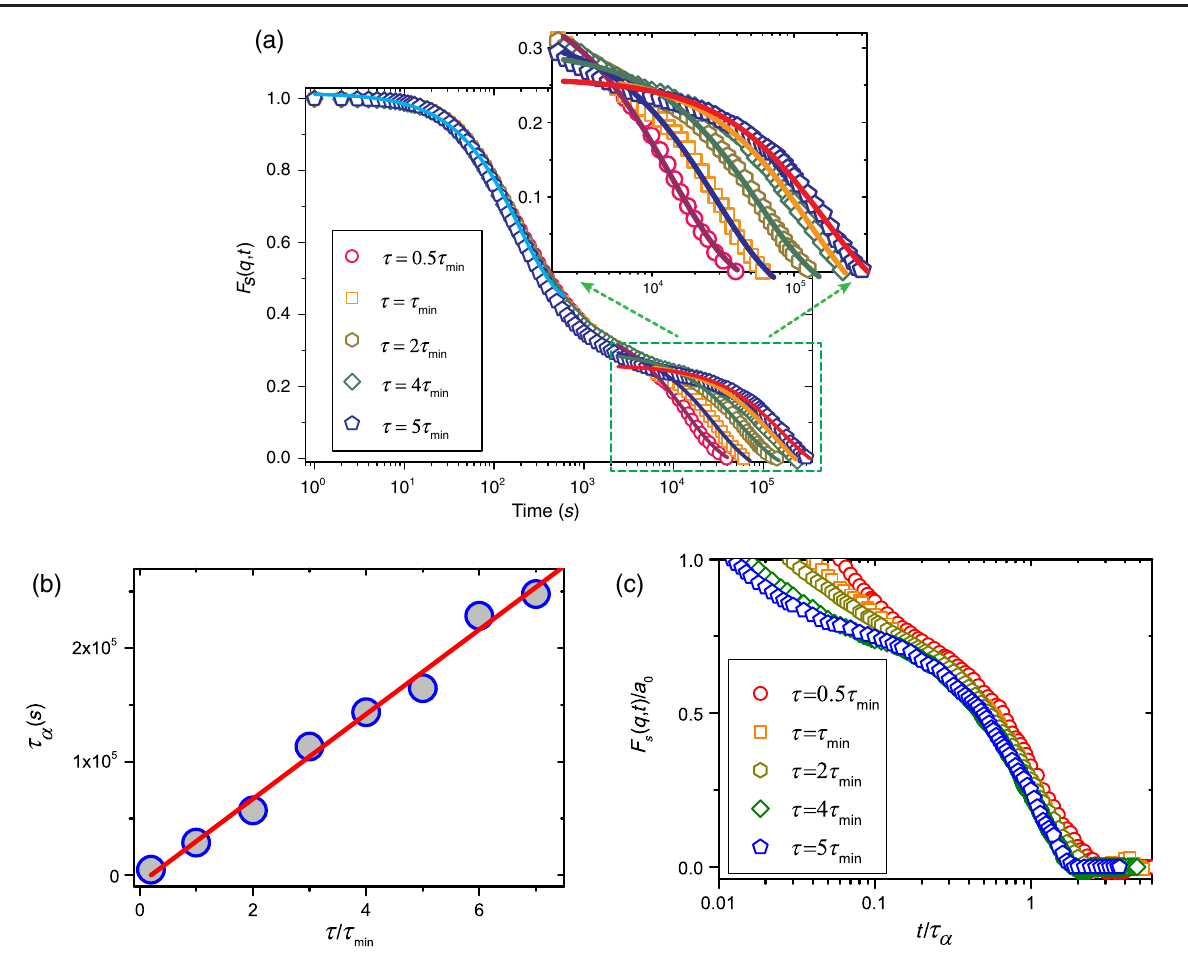
q; t Þ , shows s ð q; t Þ slows down as τ increases (from 0 . 5 τ to 5 τ ). s ð min min ). The red solid line is a linear fit ( τ α ∝ 0 . 69 τ ). min q; t Þ =a 0 as a function of the rescaled time t = τ α s ð